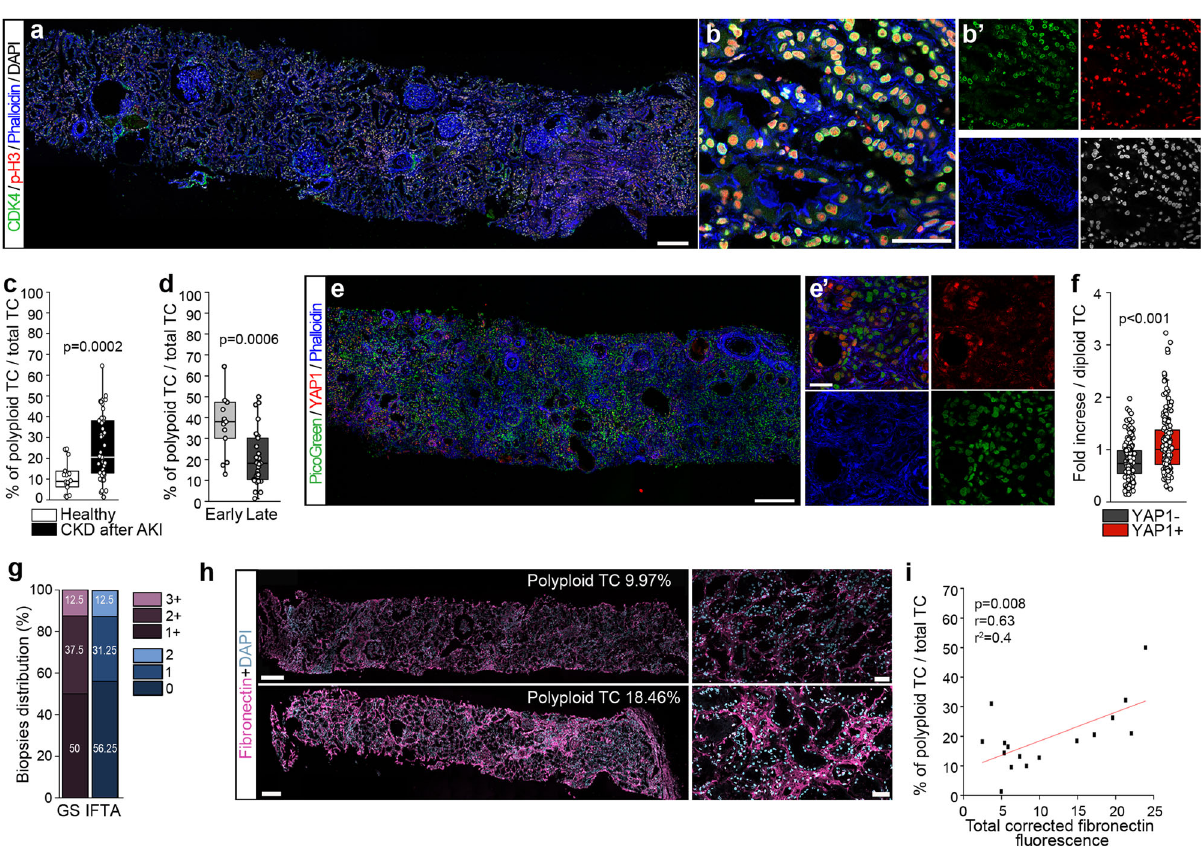
Fig. 8 | YAP1-related tubular cell (TC) polyploidization correlates with fi brosis inhumankidneybiopsies.a Representativesequentialscanningofkidneybiopsy from a CKD after AKI patient showing CDK4, p-H3 and Phalloidin staining ( n =45). DAPIcounterstainsnuclei.Bar250 µ m. b , b ’ Highermagni fi cationofkidneysection withsplitimages.Bar50 µ m. c PercentageofpolyploidTCinCKDafterAKI( n =45) vs healthy patients ( n =18). d Percentage of polyploid TC in “ early ” ( n =14) and “ late ” groups( n =31). e Representativesequentialscanningofkidneybiopsyfroma CKD after AKI patient showing YAP1 and Phalloidin staining ( n =8). PicoGreen counterstains nuclei. Bar 250 µ m. e ’ Higher magni fi cation of kidney section with splitimages.Bar25 µ m. f DNAcontentquanti fi cationofYAP1 + nuclei vs YAP1 −